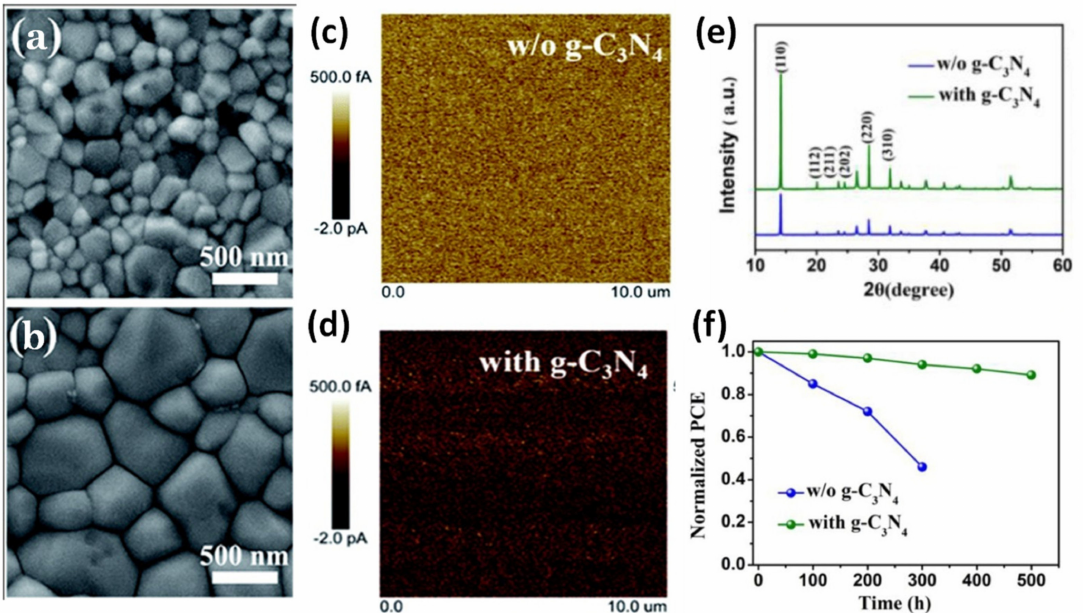
Figure 5. Top-view SEM images of the perovskite films based on ( a ) control MAPbI 3 and ( b ) 0.1 wt% g-C 3 N 4 modified MAPbI 3 film, conductive AFM images of ( c ) control MAPbI 3 and ( d ) 0.1 wt% g-C 3 N 4 modified MAPbI 3 films with a scanning area of 10 × 10 µ m 2 , ( e ) XRD patterns of control and 0.1 wt% g-C 3 N 4 modified MAPbI 3 films, and ( f ) operational stability of the encapsulated PSCs fabricated with or without g-C 3 N 4 under constant 1 sun illumination. Reproduced with permission from [96], Copyright 2019, The Royal Society of Chemistry.